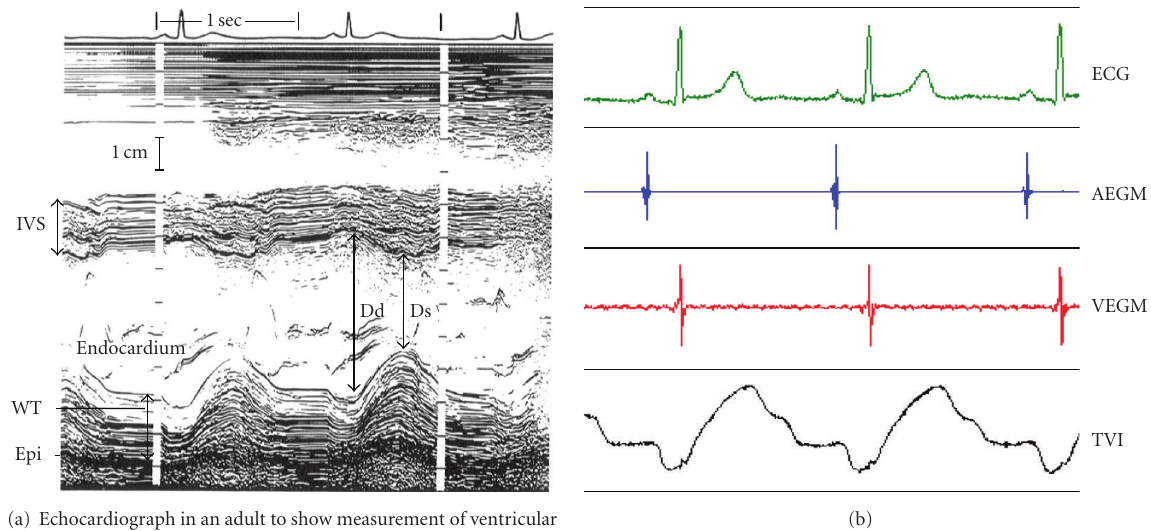
Figure 4: Trans Valvular Impedance (TVI) system (Medico, Italy). TVI waveform mirrors the time-course of ventricular volume along the cardiac cycle, detecting by M-mode Echo. TVI increases during ventricular systole and decreases during passive and active filling